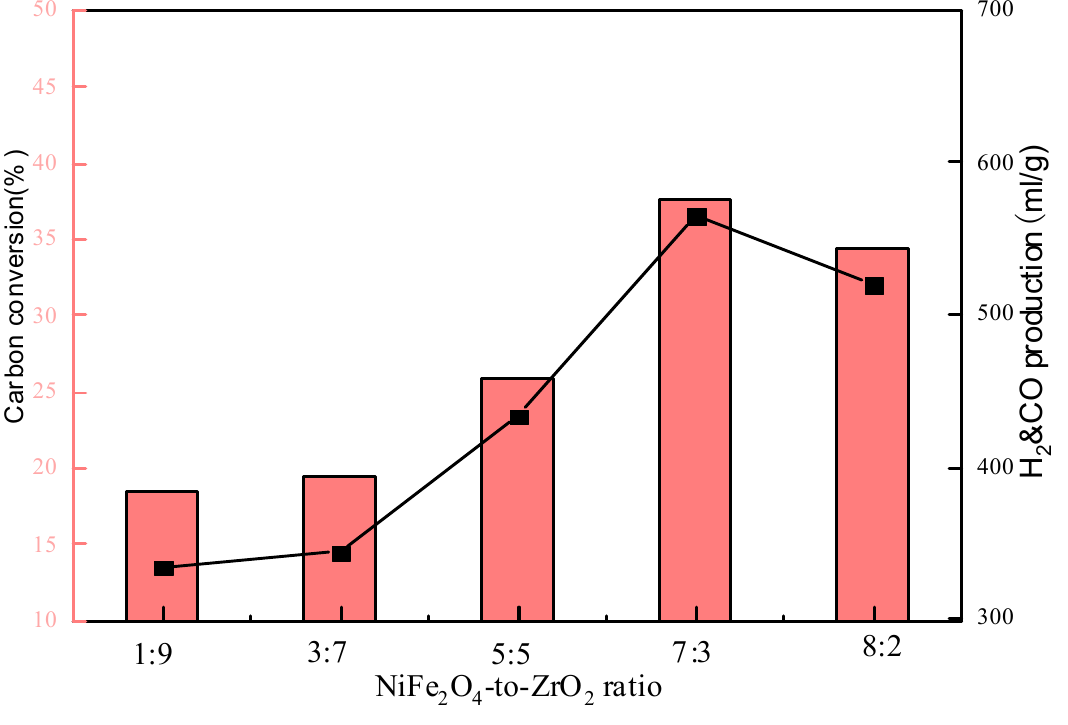
Figure 5. Effect of NiFe 2 O 4 -to-ZrO 2 ratio on Figure 5. E ff ect of NiFe 2 O 4 -to-ZrO 2 ratio on CLG.